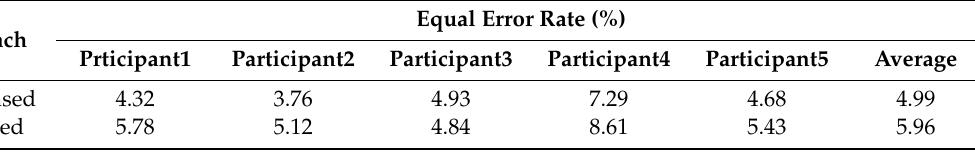
Table 2. EER (%) of trigger word detection.